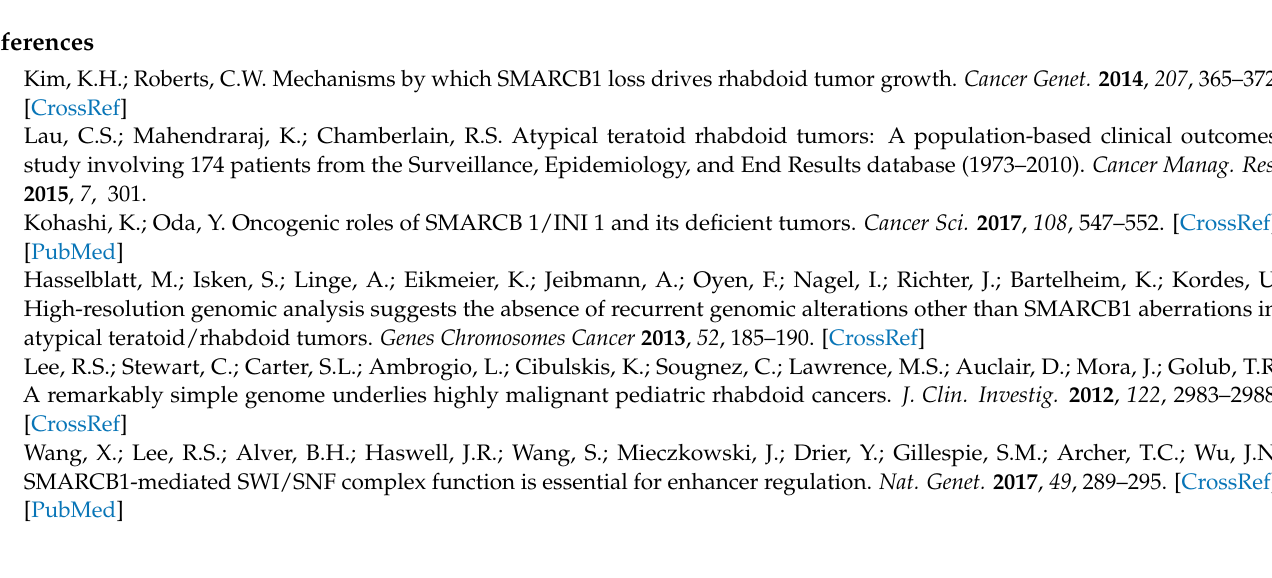
Figure S4: Gene ontology network map for differentially expressed genes in BT12 human ATRT cells treated with 10 nM panobinostat for 21 days, Figure S5: Gene ontology network map for differentially expressed genes in BT16 human ATRT cells treated with 10 nM panobinostat for 21 days, Figure S6: Gene ontology network map for differentially expressed genes in CHLA266 human ATRT cells treated with 10 nM panobinostat for 21 days, Figure S7: Full western blot images including densitometry